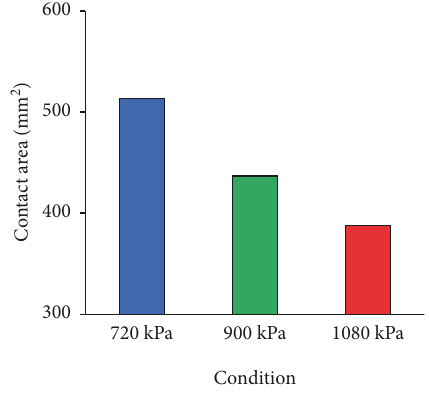
Figure 9: Contact area under different tire pressures.